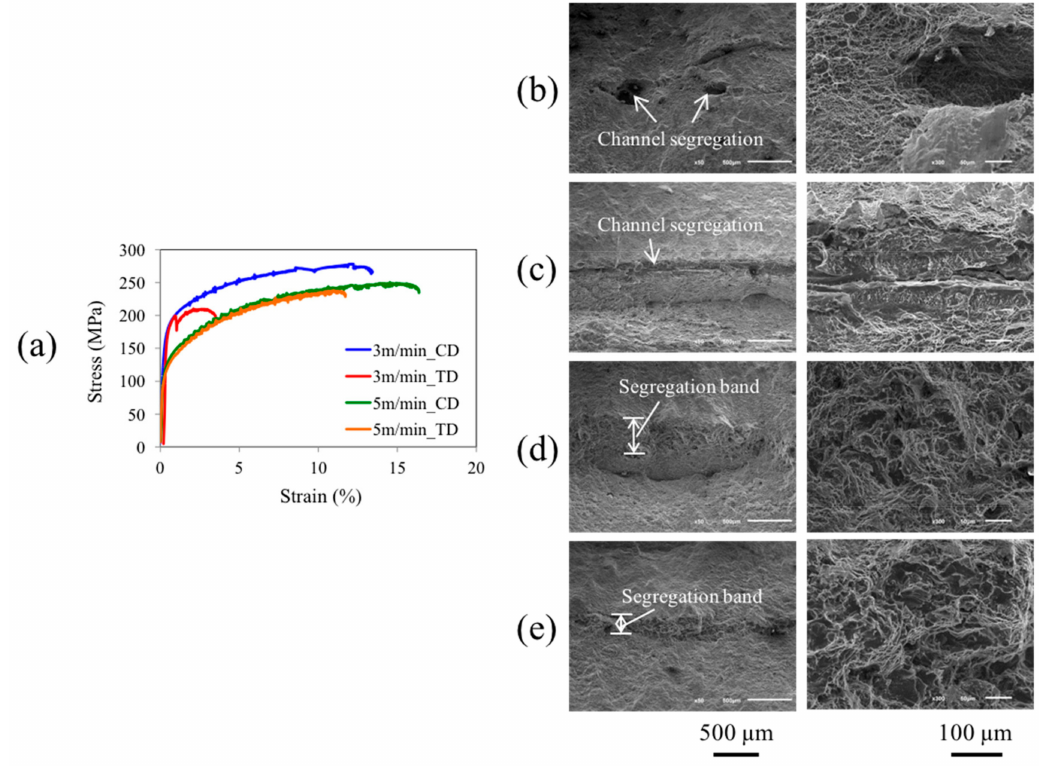
Figure 6. ( a ) Engineering stress-strain curves and SEM images of the fractured surface of the ( b ) 3 m / min, CD, ( c ) 3 m / min, TD, ( d ) 5 m / min, CD, and ( e ) 5 m / min, TD